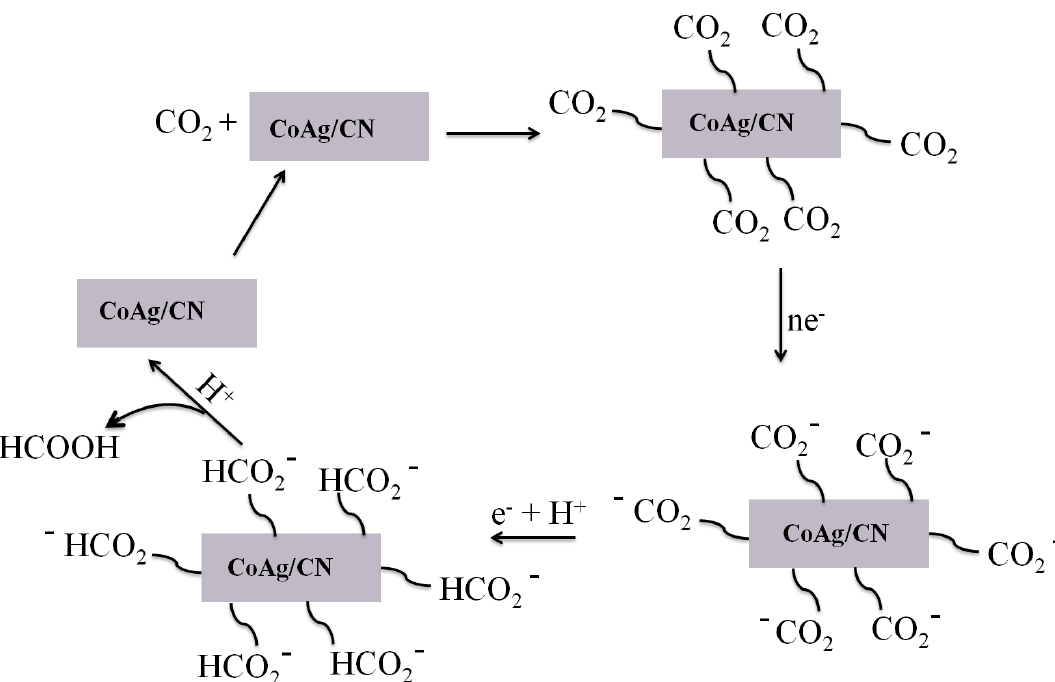
Figure 12. Possible mechanism of CO 2 conversion to HCOOH on the CoAg/CN surface.